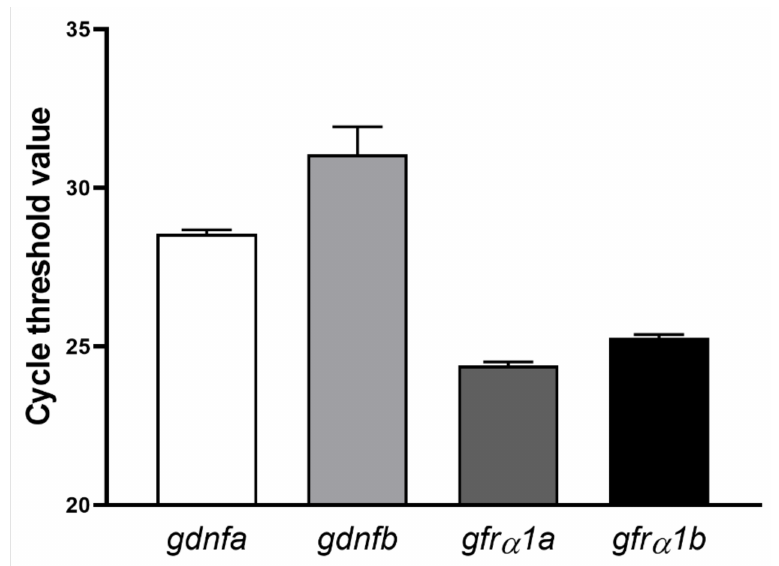
Figure 3. Number of amplification cycles (cycle threshold (Ct)) for both ligands ( gdnfa and gdnfb ) and receptors ( grf α 1a and grf α 1b ) in zebrafish testes. Bars represent the mean ± SEM ( n = 4) for each